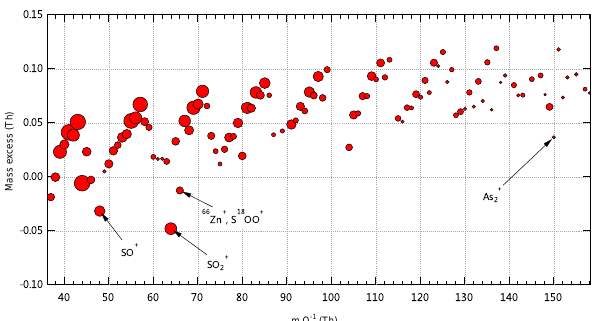
Figure 13. Mass excess plot for the isobaric peaks visible in a MS from the underground mine data. The peaks containing the Arsenic and SO x ions are indicated. The data points are sized according to the log of the peak intensity.